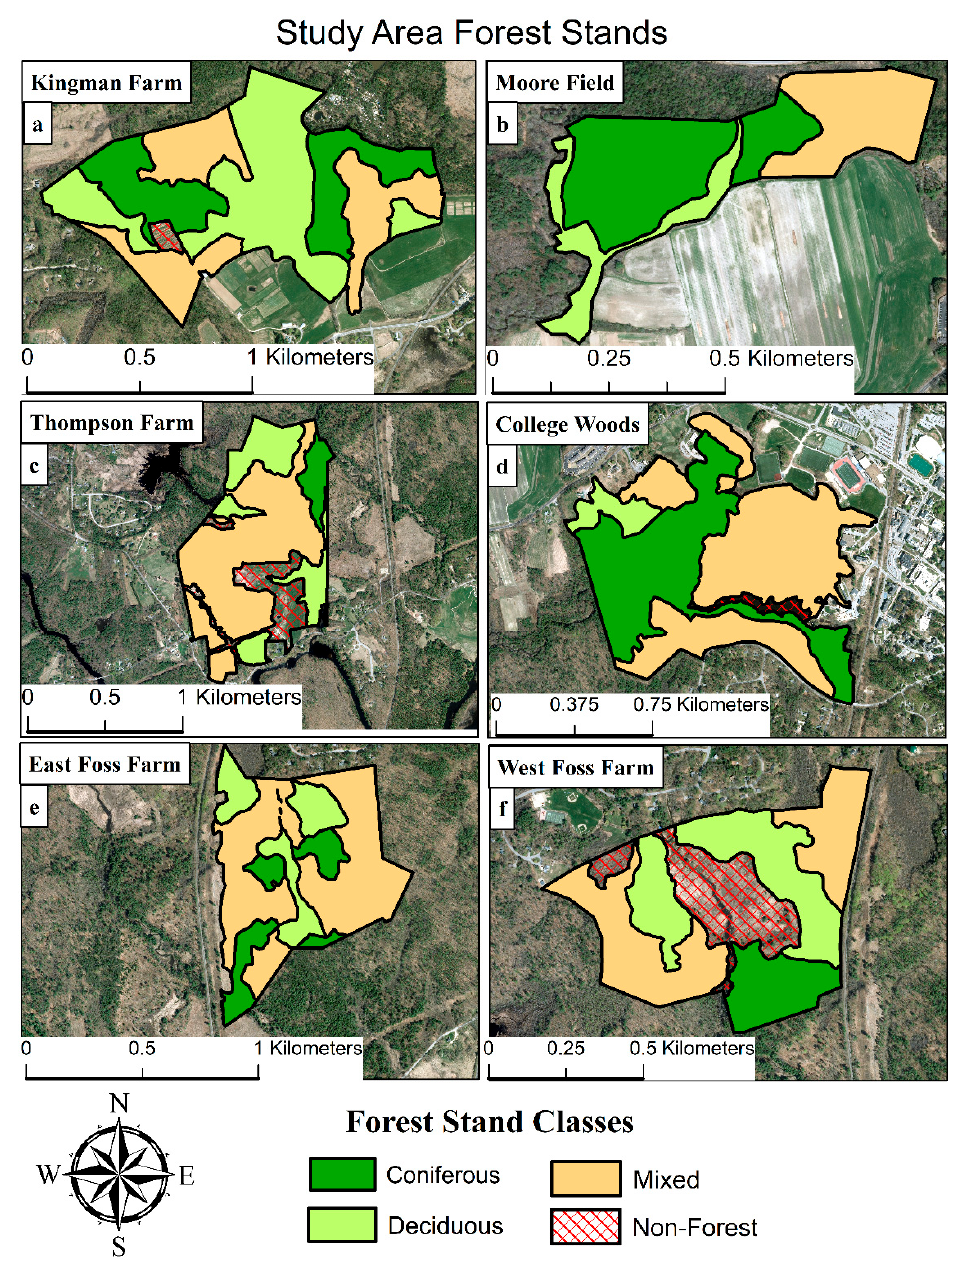
Figure 3. Ground-based forest stands digitized from CFI-plot classifications. Pictured are (Top left to Figure 3. Ground ‐ based forest stands digitized from CFI ‐ plot classifications. Pictured are (Top left to bottom right): ( a ) Kingman Farm, ( b ) Moore Field, ( c ) Thompson Farm, ( d ) College Woods, ( e ) East bottom right): (a) Kingman Farm, (b) Moore Field, (c) Thompson Farm, (d) College Woods, (e) East Foss Farm, and ( f ) West Foss Foss Farm, and (f) West Foss Farm.